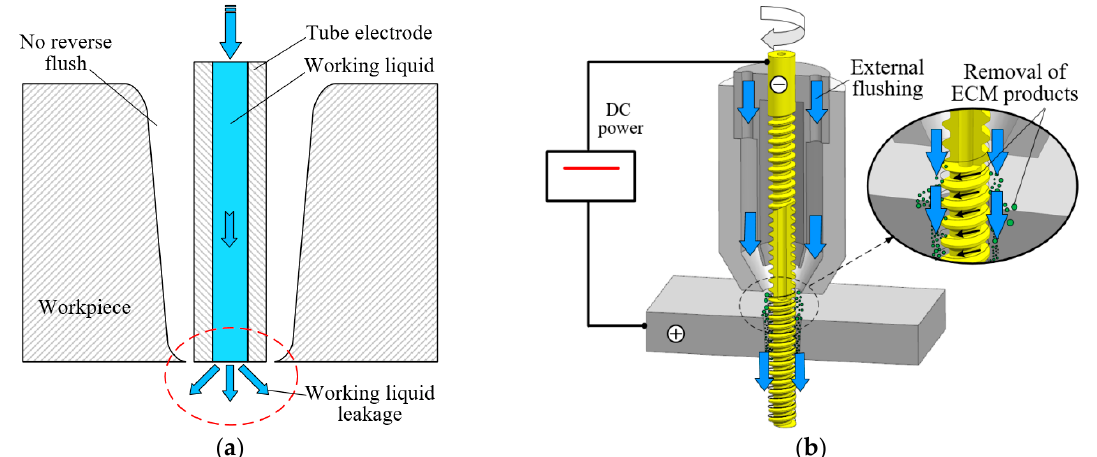
Figure 1. Schematic diagram of electrochemical reaming using a helical tube electrode together with lateral flushing: ( a ) after the electrical discharge machining (EDM) process; ( b ) electrochemical reaming as post-processing. ECM: electrochemical machining.